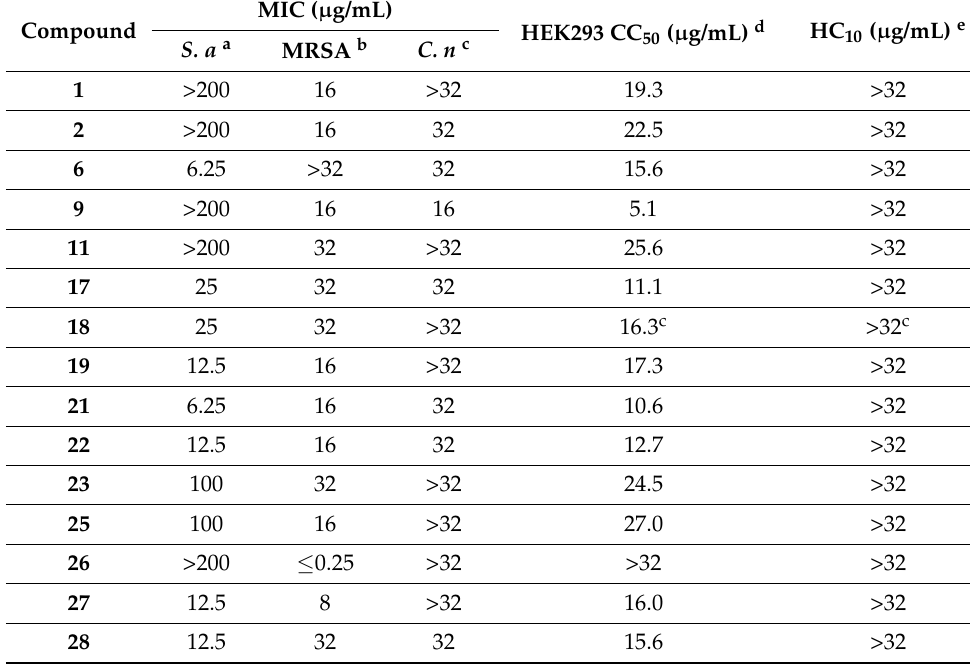
Table 1. Antimicrobial (MIC, µ g/mL), cytotoxic ( µ g/mL) and hemolytic ( µ g/mL) activities of selected